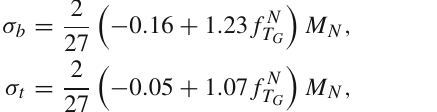
Values of the f N for the proton and neutron obtained using our estimates of (cid:7) π N and σ s as described in T q , G the text, assuming z = 1 . 49. The values for the heavy quarks are obtained from those for light quarks and gluons via an O (α 3 s ) calculation in perturbative